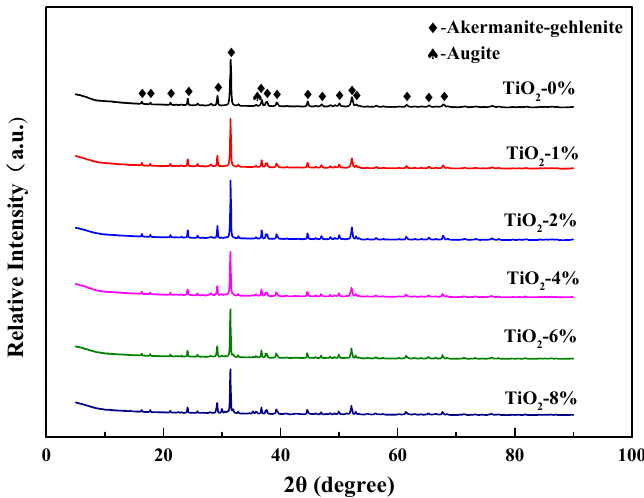
Figure 7. X-ray di ff raction patterns of Figure 7. X ‐ ray diffraction patterns of glass ‐ ceramics.